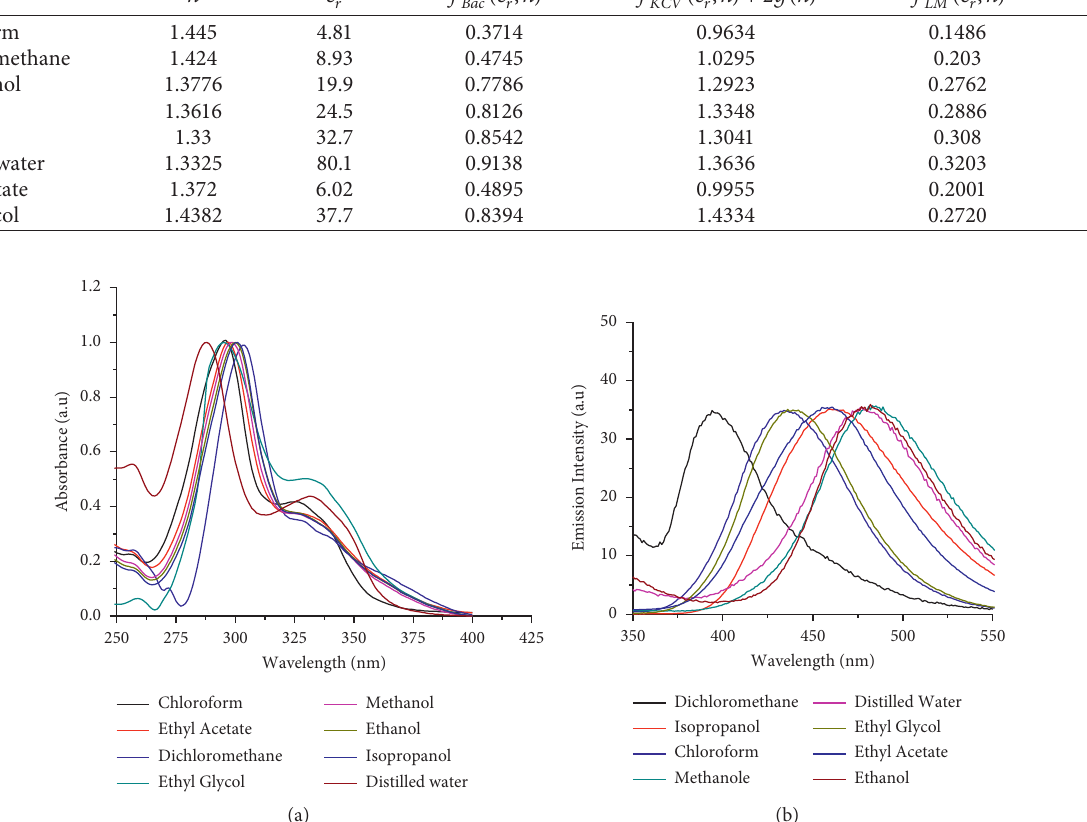
Figure 2: (a) UV/Vis absorption spectra and (b) emission spectra of LVF in solvents with different solvent